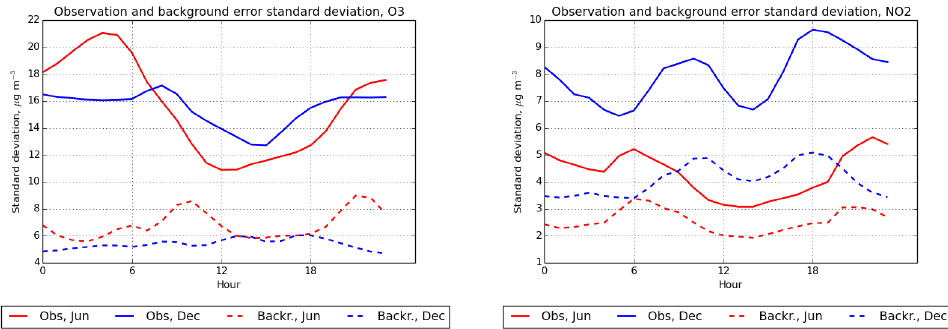
Figure 4. Diagnosed background (dashed) and observation error (solid lines) standard deviations (µgm − 3 ) on rural stations for O 3 (left) and NO 2 (right). Red lines correspond to the calibration made for June 2011, blue lines correspond to calibration for December